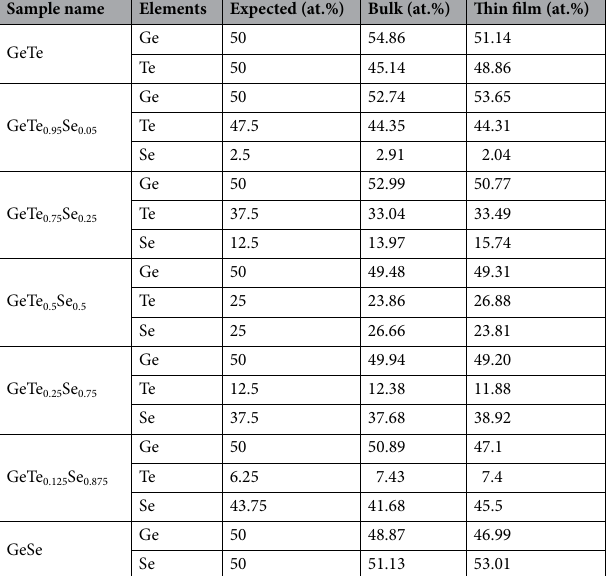
Table 2. EDS data for bulk powder and thin films are enlisted in the